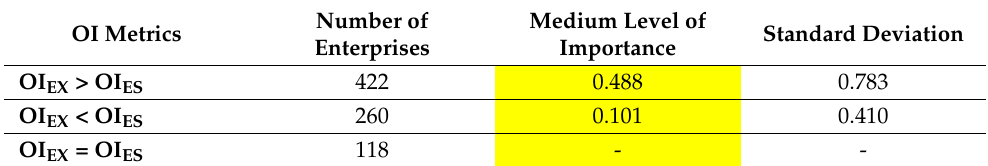
Table 8. Value of OI metrics for the verification of H1a ( p = 0.00026 <